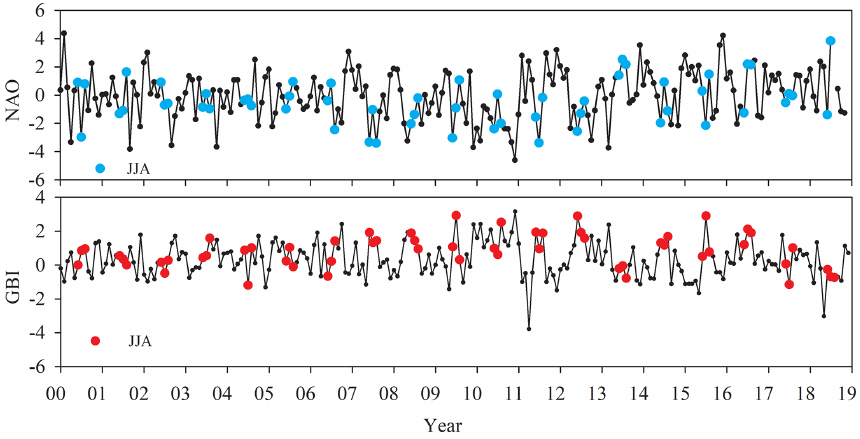
Figure 3. Time series of monthly average NAO index and GBI for which the blue and red dots are values for June, July and August (JJA).